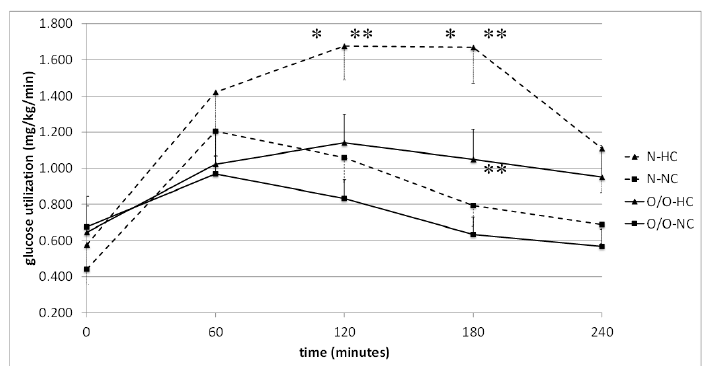
Figure 4. Glucose utilization (mg/kg/min) in people with normal body weight (N, the broken line) and overweight/obese people (O/O, the solid line) in fasting state (time 0 min) and after consumption (time 60–240 min) of a high-carbohydrate meal (HC) and a normo-carbohydrate meal (NC). The results are presented as mean values ± SE. The comparison between study groups N and O/O * p < 0.05; the comparison between meals HC and NC ** p < 0.05.